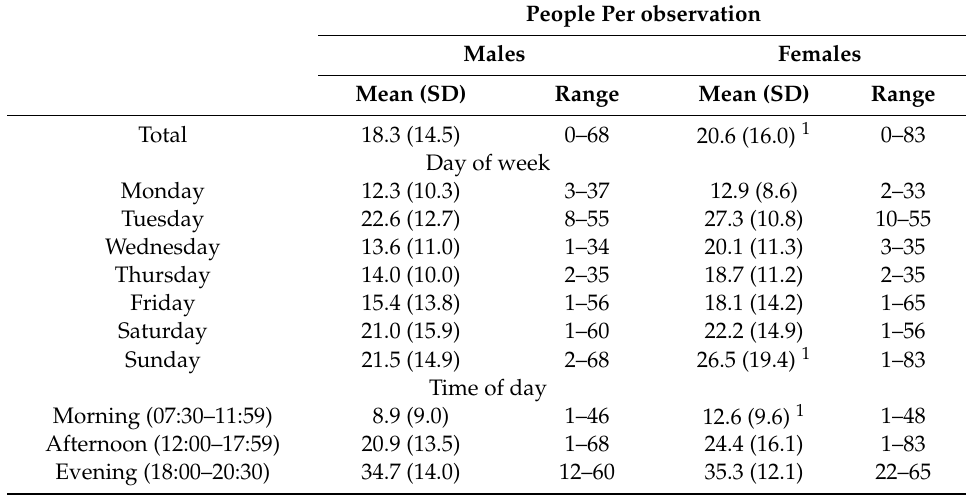
Table 3. Differences in river exposure by sex by in, on, or beside the river; time of day; and day of week.